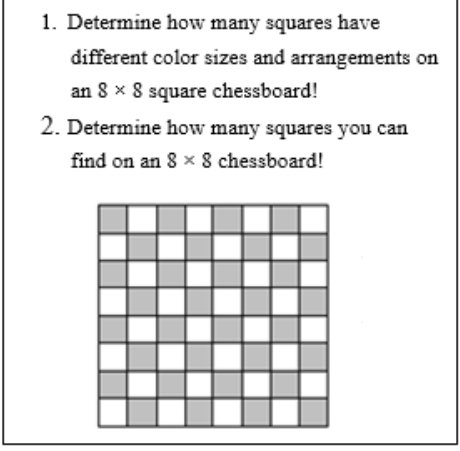
Figure 2. Adapted Mathematical Prob-